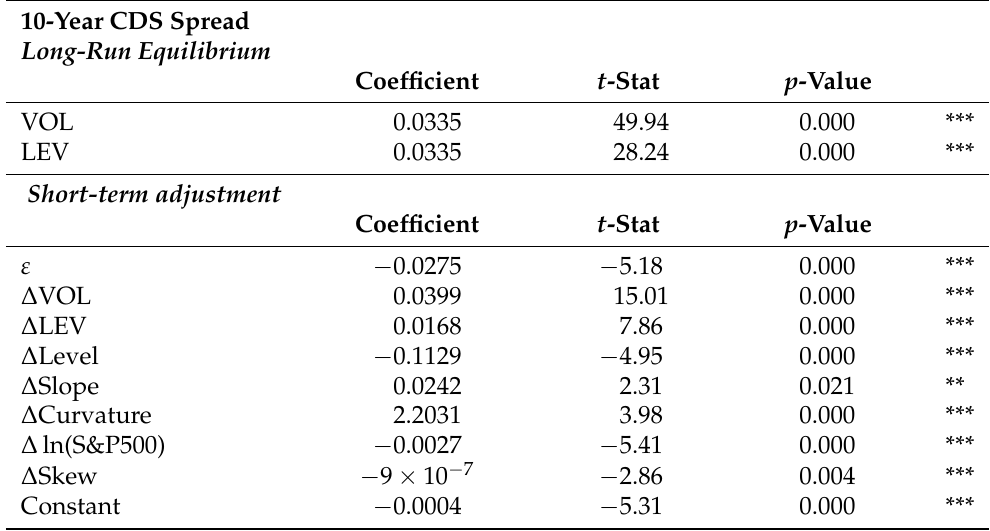
Table 8. ECM for 10-year CDS spreads. All the variables which structural models predict to influence the change in spreads are statistically significant and have the predicted signs. The loading on the cointegrating equation ( ε ) is negative and statistically significant, thus confirming the existence of a long-term equilibrium to which spreads, volatility and leverage converge. This model constrains the long-run coefficient vector to be equal across panels while allowing for group-specific short-run and adjustment coefficients. The averaged short-run parameter estimates are